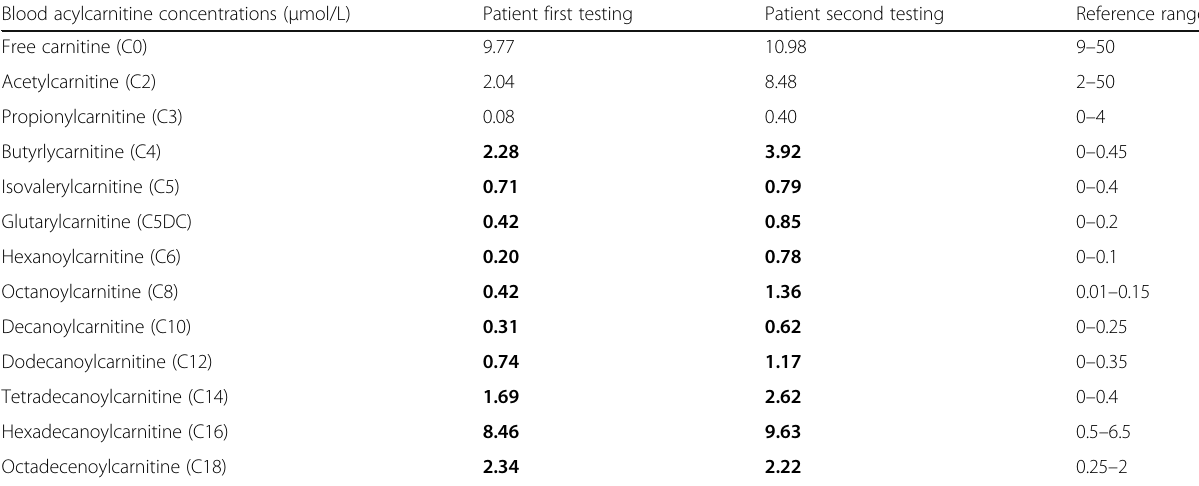
Table 1 Dried blood spot acylcarnitine results in each separate test Blood acylcarnitine concentrations ( μ mol/L)